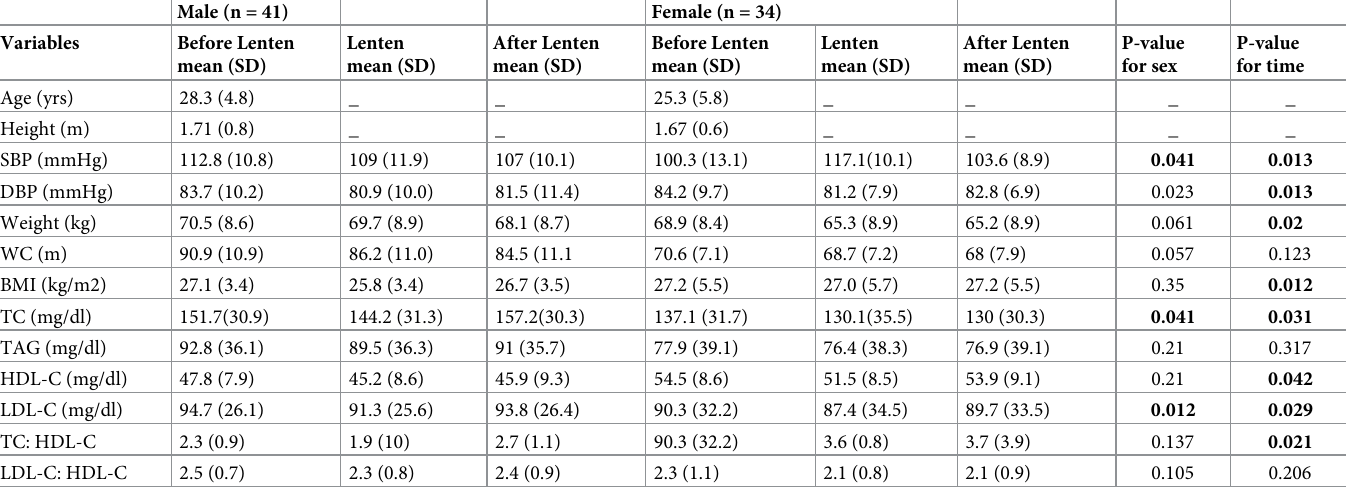
Table 1. Comparison of changes in anthropometric and biochemical profiles by gender, and time on a group of 75 Ethiopian Orthodox Christian fasting subjects. All values are expressed as mean ± SD. Male (n = 41) Female (n = 34) Variables Before Lenten Lenten After Lenten mean (SD) mean (SD) mean